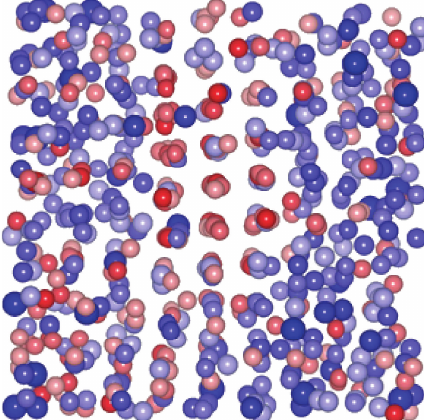
Figure 3: (Color online) A region including the crystal-like super- cluster from a snapshot of the model simulation—incorporating fluctuation electron microscopy data—of the Zr 50 Cu 45 Al 5 metallic glass at 300 ∘ C (from [2]). The atomic separation distances of the middle zone are about 0.25 nm. This is a first realistic image of a crystal embryo in a glass; this object should not be confused with the concept of short-range order in ideal